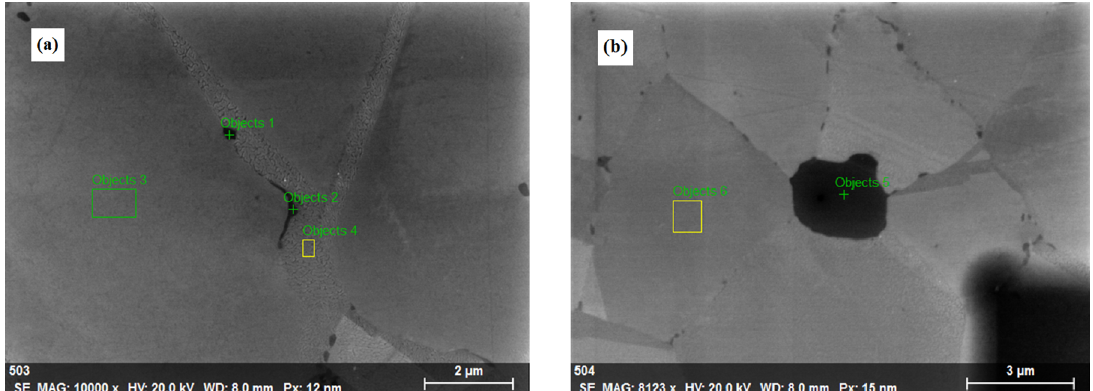
Figure 6 . Images obtained by detection of secondary electrons from regions analyzed by EDS (a) objects 1, 2, 3 and 4 and (b) objects 5 and